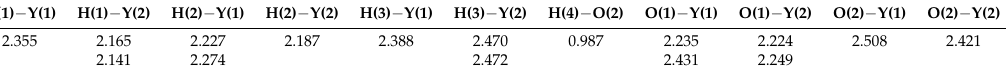
Table 2. Equilibrium interatomic distances (Å) in Y 2 H 3 O(OH).